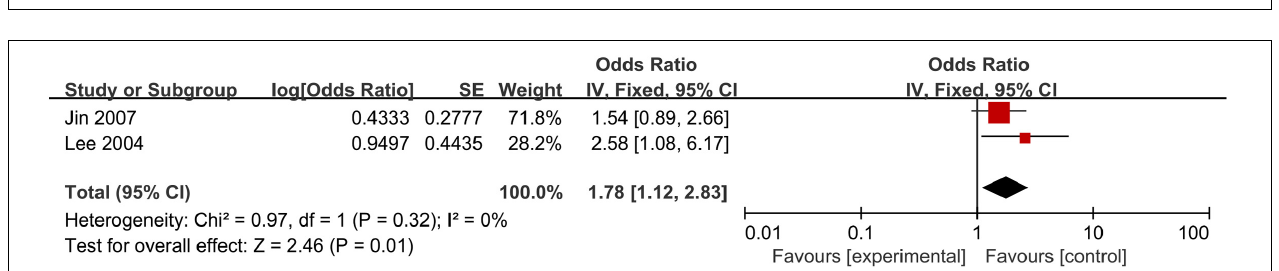
FIGURE 6 | Relationship H. pylori stool antigen test and CHD.